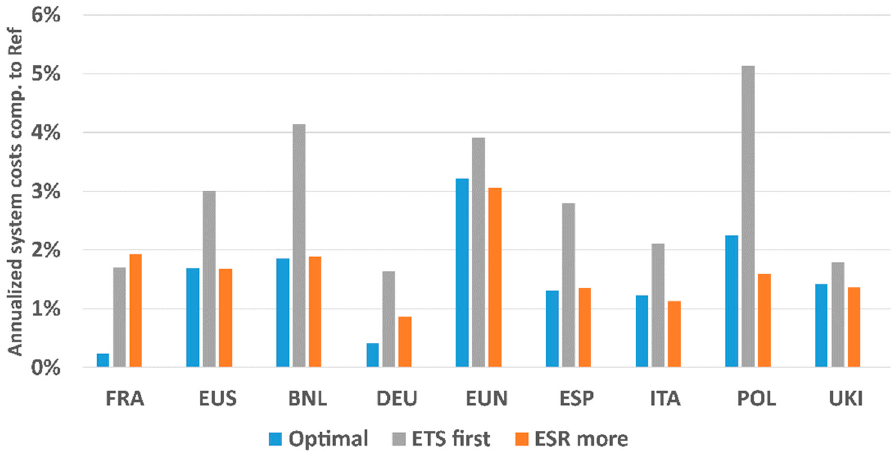
Figure 8. Deviation of the annualised system costs in 2030 compared to the reference scenario.